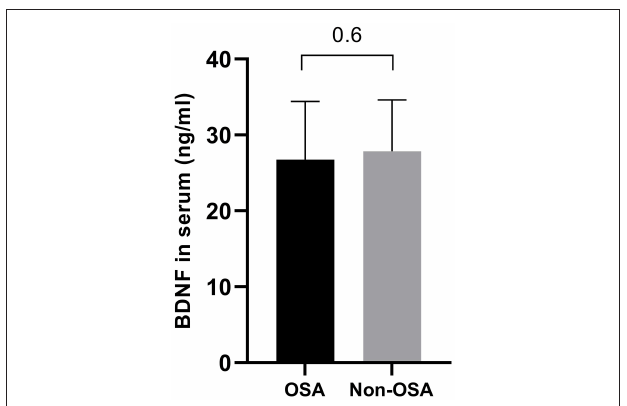
FIGURE 1 | Comparison of BDNF levels between patients with (oAHI ≥ 2) and without OSA (oAHI < 2). The BDNF level is comparable in both groups (26.75 ± 7.66 ng/ml vs. 27.87 ± 6.77 ng/ml, p = 0.6).